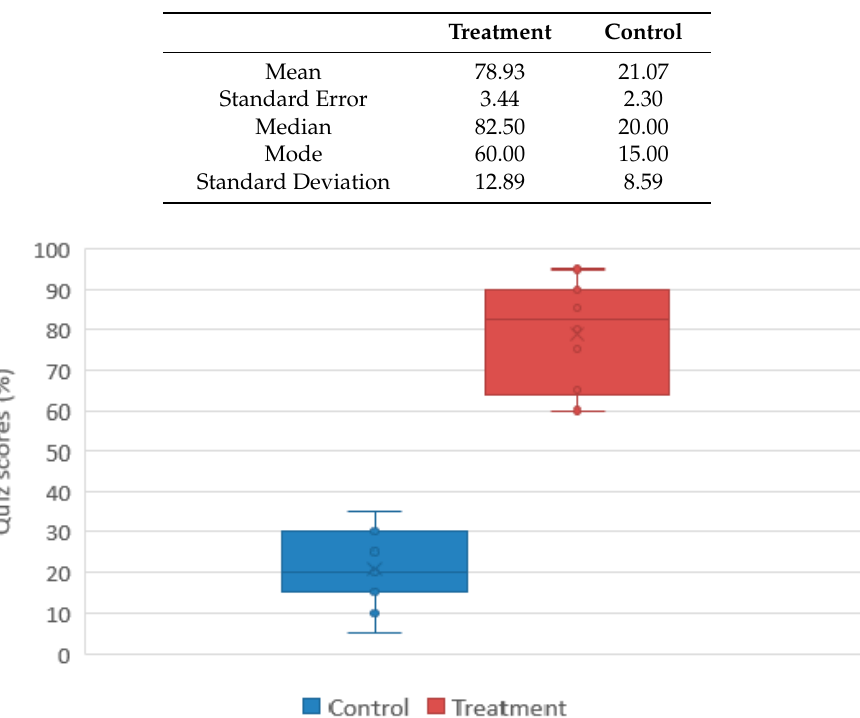
Figure 5. Responses on health literacy experience questionnaire.